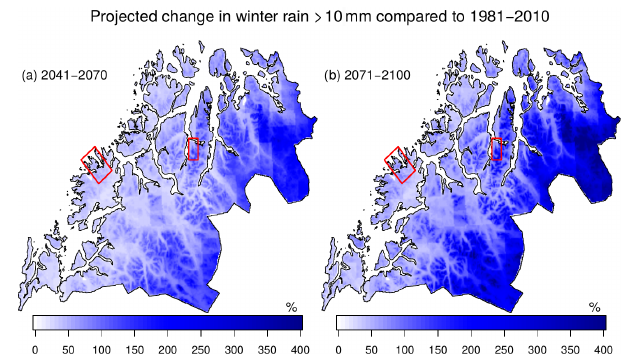
Figure 15. Projected change in the frequency of rainfall events ex- ceeding 10mm during winter (October–April) between 1981–2010 and (a) the near future (2041–2070) and between 1981–2010 and (b) the far future (2071–2100). Note that the legend differs from other figures, going from 0% to